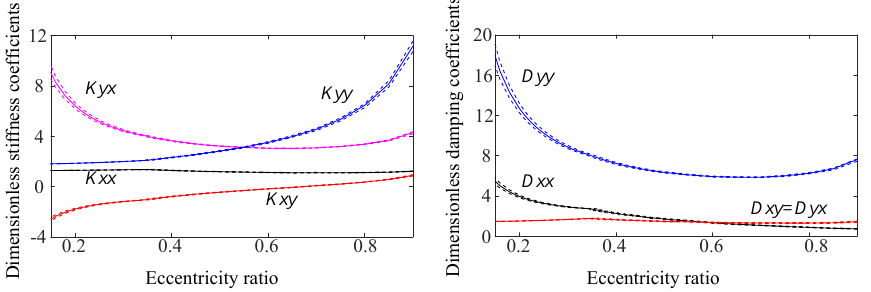
Figure 9. Mean values of dimensionless dynamic coefficients by gPC expansion and their 95% confidence intervals plotted with dashed lines as the boundary.